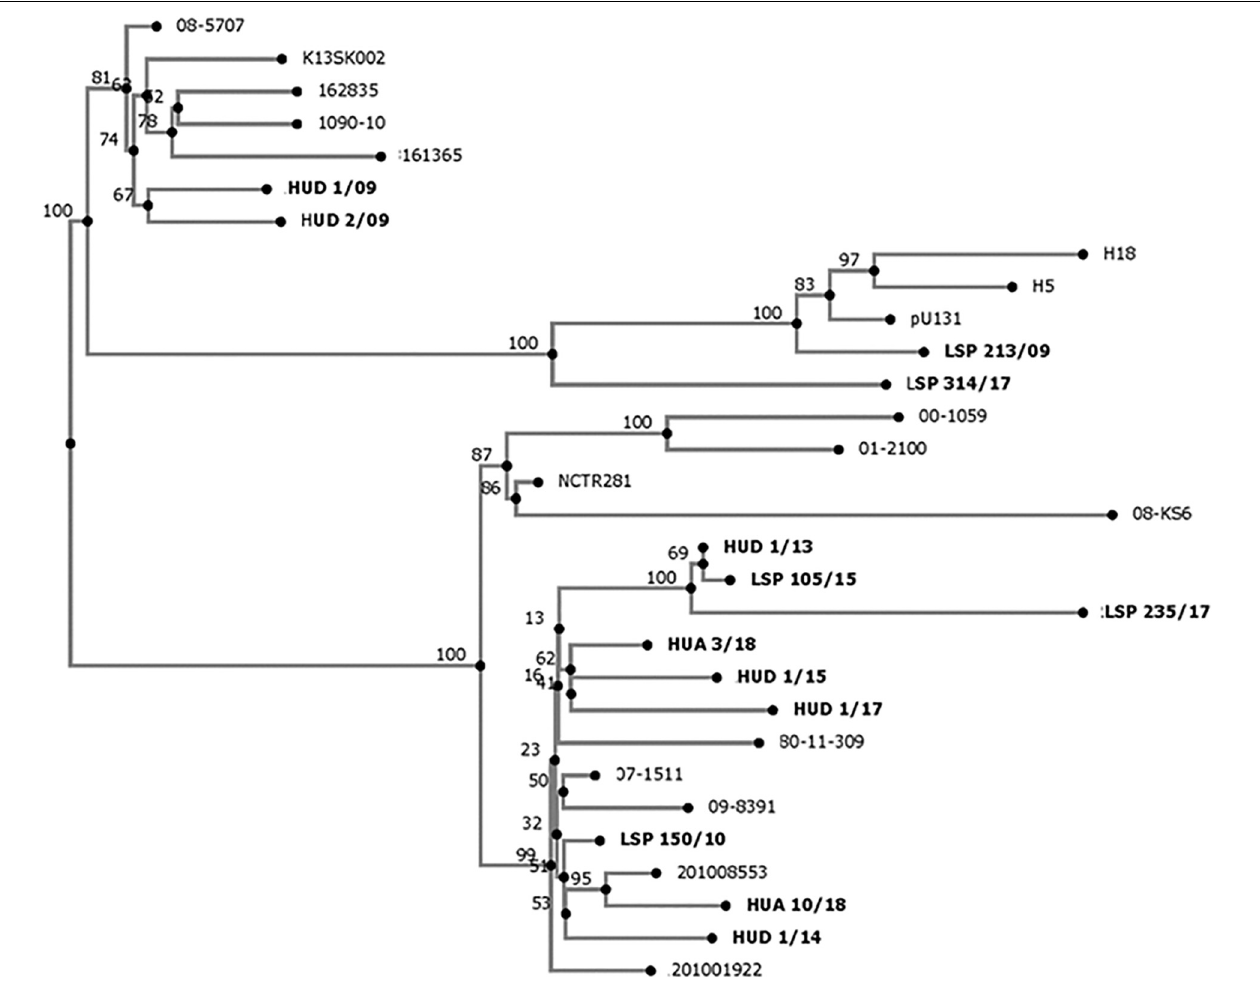
FIGURE 2 | Phylogenetic tree showing the relationships between Salmonella enterica serovar Kentucky ST198-Cip R isolates from Spanish hospitals (highlighted in bold), and other S. Kentucky ST198 isolates. The whole genome single nucleotide polymorphism based analysis was established with the CSI Phylogeny 1.4 (https://cge.cbs.dtu.dk/services/CSIPhylogeny/), using the genome of S . Kentucky strain 201001922 (accession number CP028357) as reference. Numbers at the nodes represent bootstrap values based on 1,000